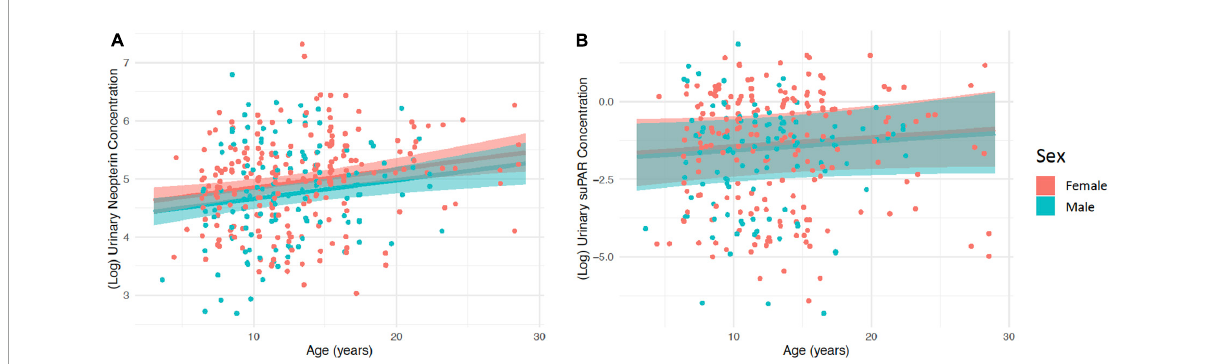
FIGURE1 The relationship between age and (A) (log) urinary neopterin concentration (ng/mg creatinine), and (B) (log) urinary suPAR concentration (ng/mg creatinine), for both males and females. Predicted values are shown with 95% confidence intervals. Points represent the raw (log) urinary neopterin or suPAR concentration values.